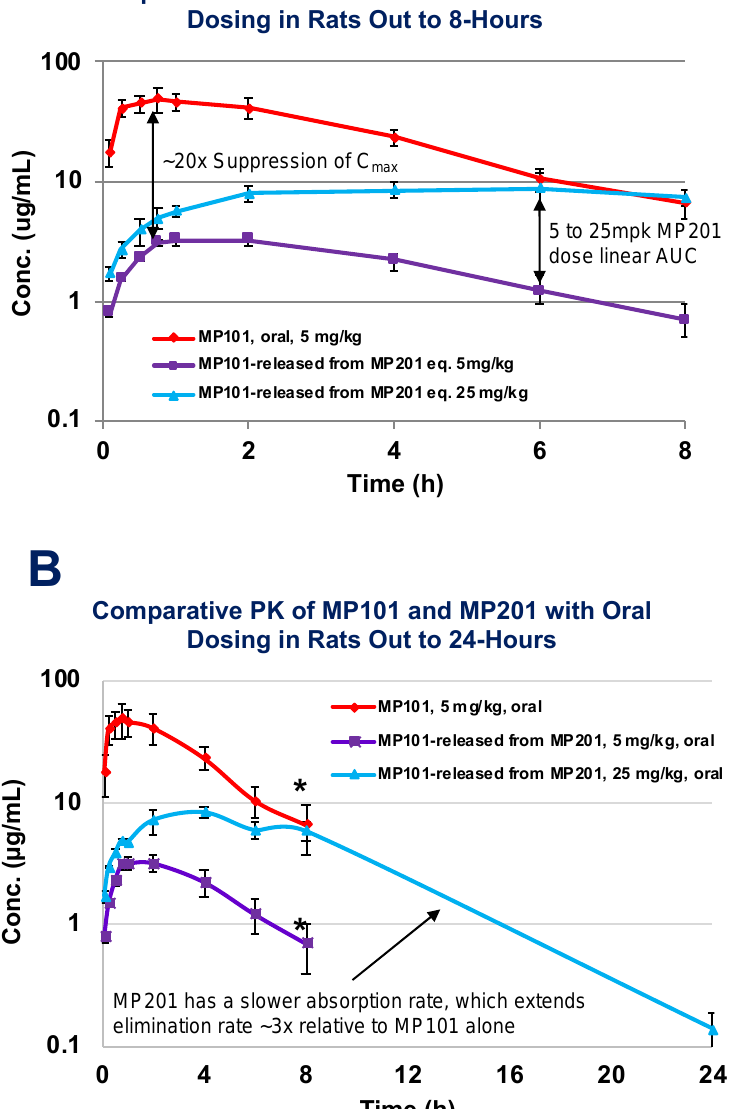
Figure 4. Comparative Oral PK in Rats of MP101 (DNP) vs. MP201 (prodrug of DNP). Male Sprague-